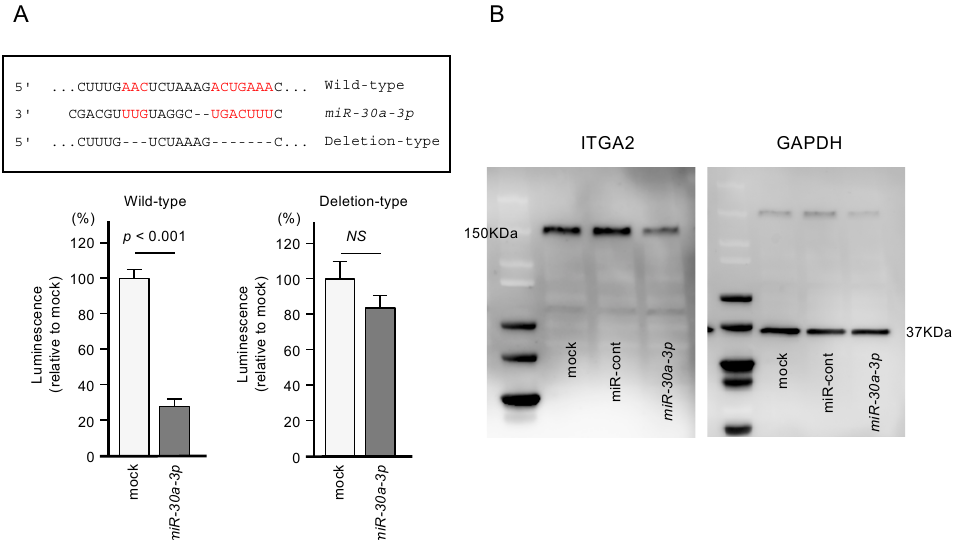
Figure 6. Direct regulation of ITGA2 by miR-30a-3p in PANC-1 cells. ( A ) The TargetScan database showed that one putative binding site of miR-30a-3p was annotated in the 3 ′ -UTR of ITGA2 . Dual luciferase reporter assays showed that luminescence activities were reduced by co-transfection of PANC-1 cells with wild-type vector (containing miR-30a-3p binding sites) and miR-30a-3p. Normalized data were calculated as Renilla / firefly luciferase activity ratios. ( B ) Protein expression levels of ITGA2 were significantly reduced by miR-30a-3p transfection to PANC-1 cells (48 h after the transfection). Whole Western blotting images are shown. GAPDH was used as an internal control.